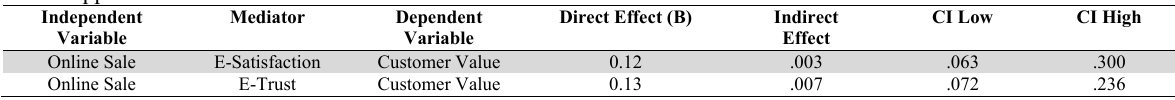
Bootstrapped mediation results Independent Mediator Dependent Variable